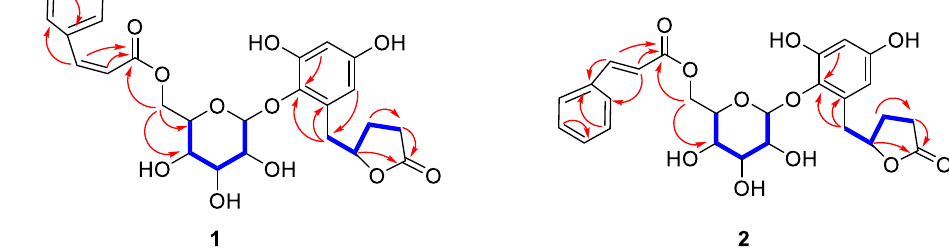
Figure 1. The key HMBC (H → C) and 1 H- 1 H COSY correlations of compounds 1 – 2 Figure 1 . The key HMBC (H → C) and 1 H- 1 H COSY correlations of compounds 1 – 2.